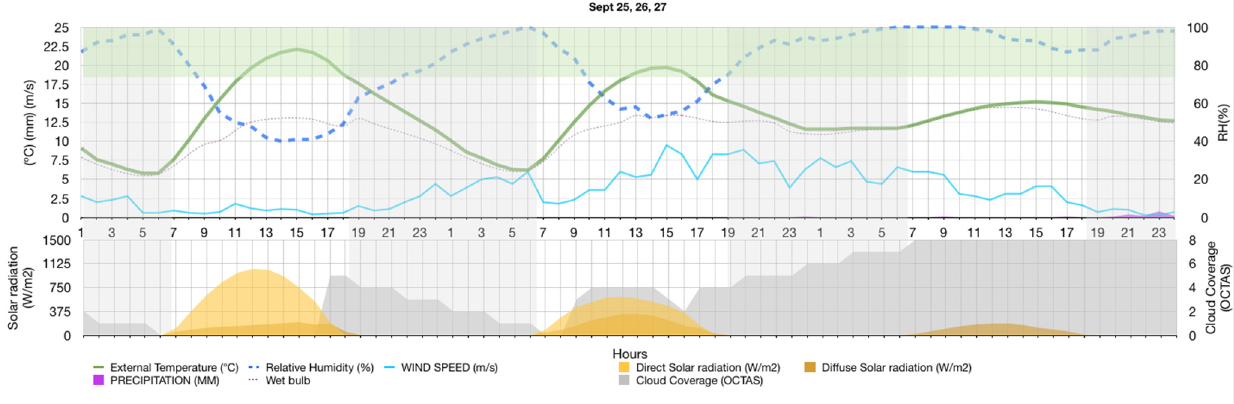
Figure 14. Fluctuations of external air temperatures over three typical days in the city